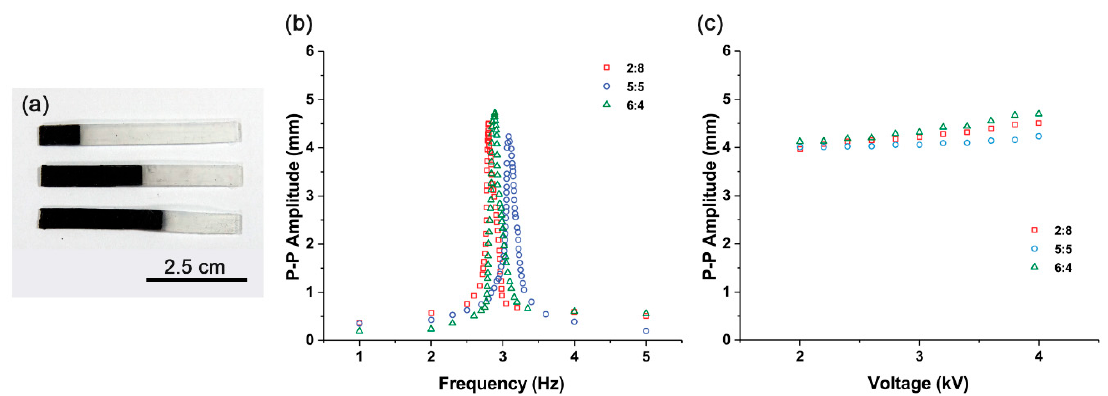
Figure 8. ( a ) Composite actuators with pure silicone-Fe 3 O 4 and silicone mixture. From top to bottom: 2:8, 5:5, and 6:4. ( b ) Frequency responses of pure silicone-Fe 3 O 4 and silicone mixture composite actuators with different Fe 3 O 4 and silicone mixture portions. ( c ) Peak-to-peak amplitude changes observed at different voltage input peak-to-peak values from 2 to 4 kV in pure silicone-Fe 3 O 4 and silicone mixture composite actuators with different Fe 3 O 4 and silicone mixture portions.